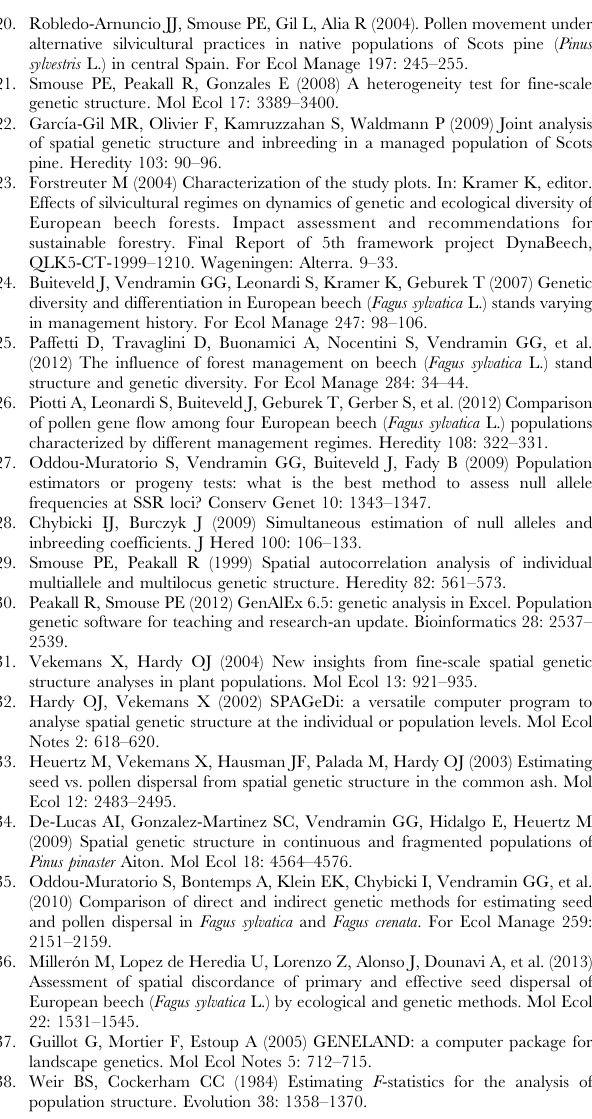
Figure S1 Bayesian clustering results. Distribution of results from the 10 repetitions of GENELAND analyses for each plot. The highest median number of clusters of the 10 repetitions was chosen as the most representative one for each plot. Table S1 Stand characteristics of the 10 study plots. For each social class the mean value of tree diameter at breast height and height, the stem number, the basal area and total volume are reported. Table S2 Heterogeneity tests of SGS between disturbed and undisturbed plots using GenAlEx (Peakall & Smouse [ 30 ] ). The reported values represent the degree of